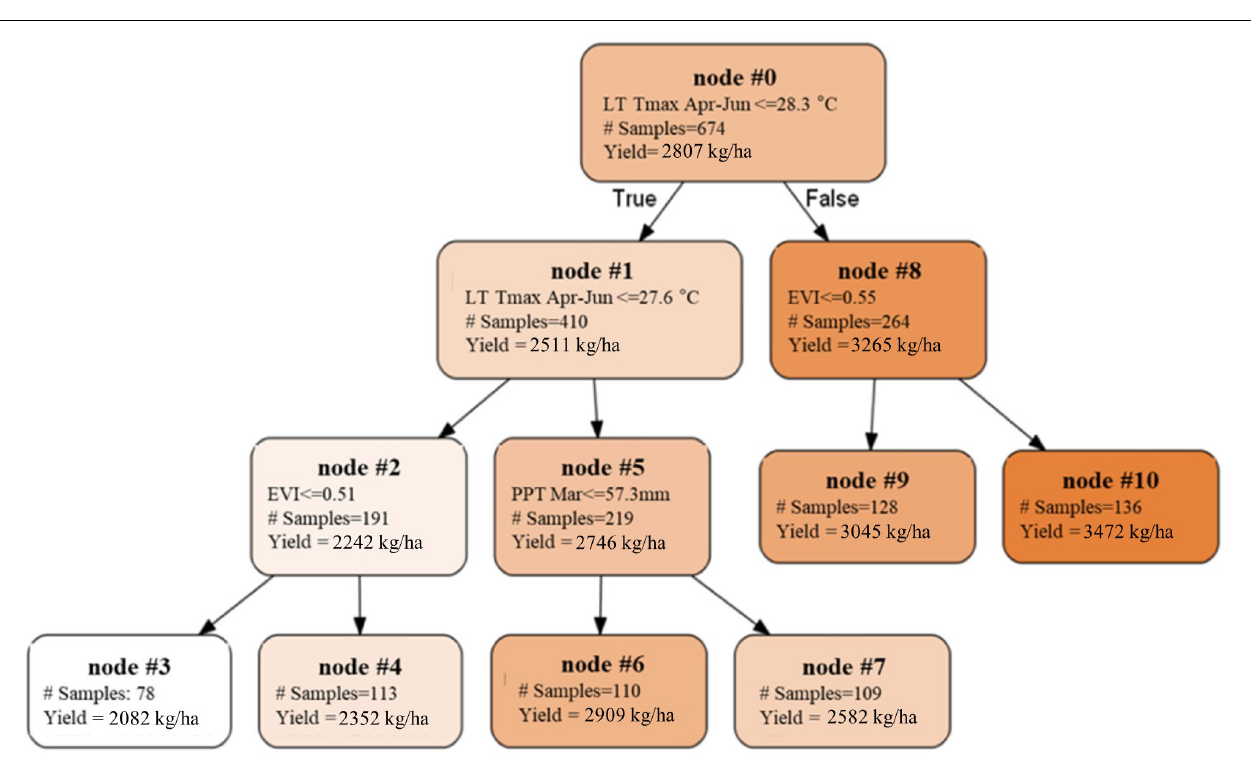
FIGURE 10 | Single decision tree built upon mature orchards using five important variables as predictors. Nodes with higher yields were represented with darker